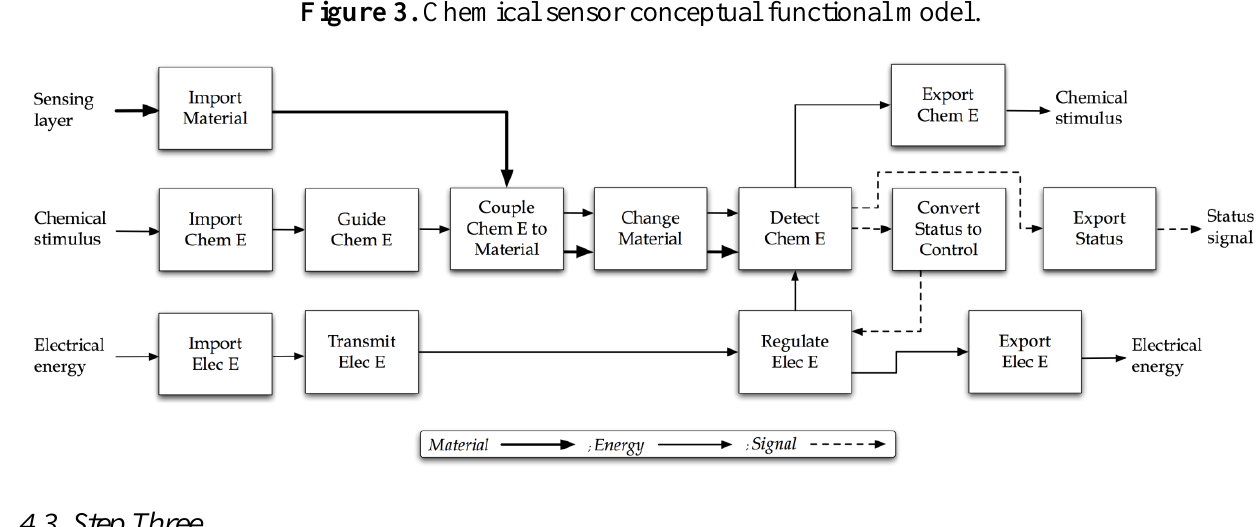
Figure 3. Chemical sensor conceptual functional